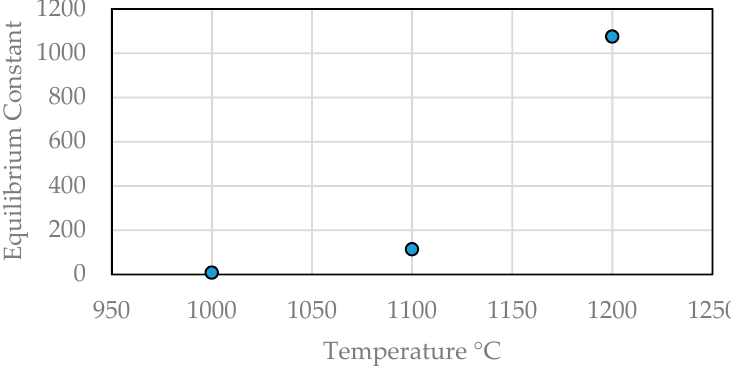
Figure 19. Effect of temperature on the equilibrium constant of the reduction reaction of MnO to Mn 7 C 3 .